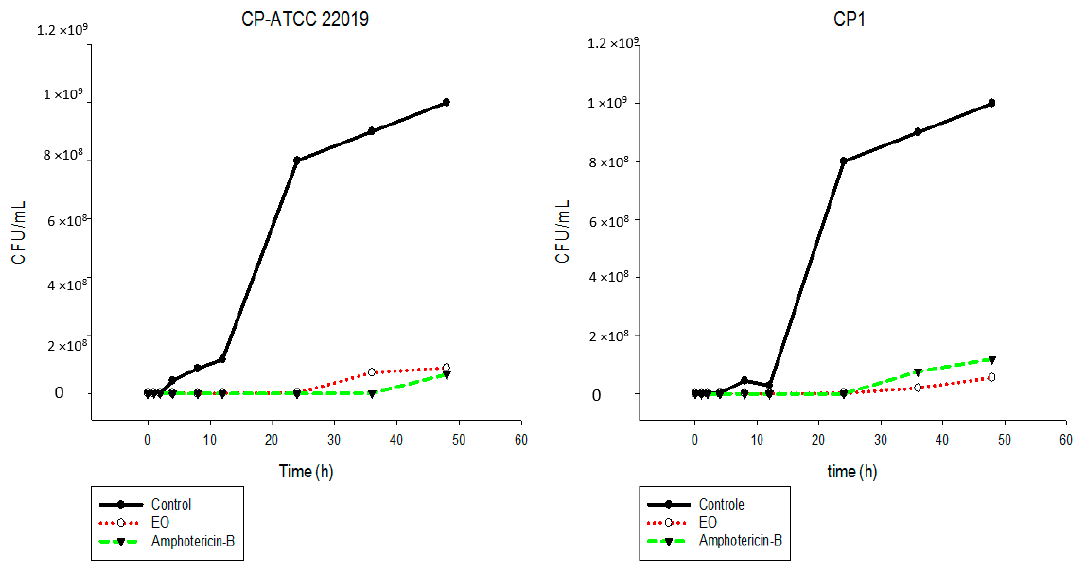
Figure 6. Time-kill curves of C. parapsilosis ATCC 22019 and CP1 following exposure to the essential oil of C. nardus and amphotericin-B. Control represents the untreated Candida cells.